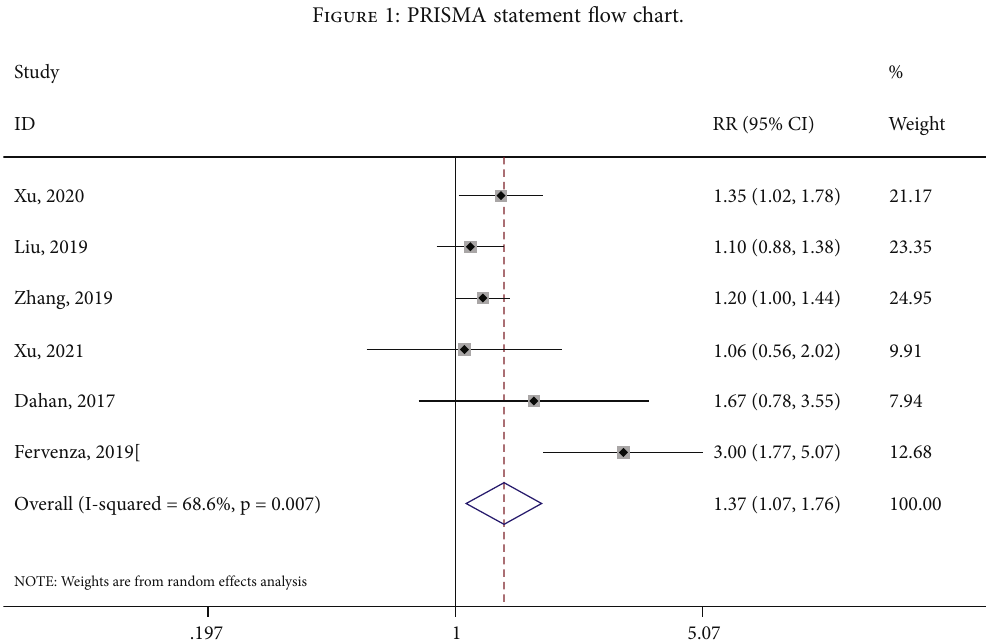
Figure 2: Forest plot of the total e ff ective